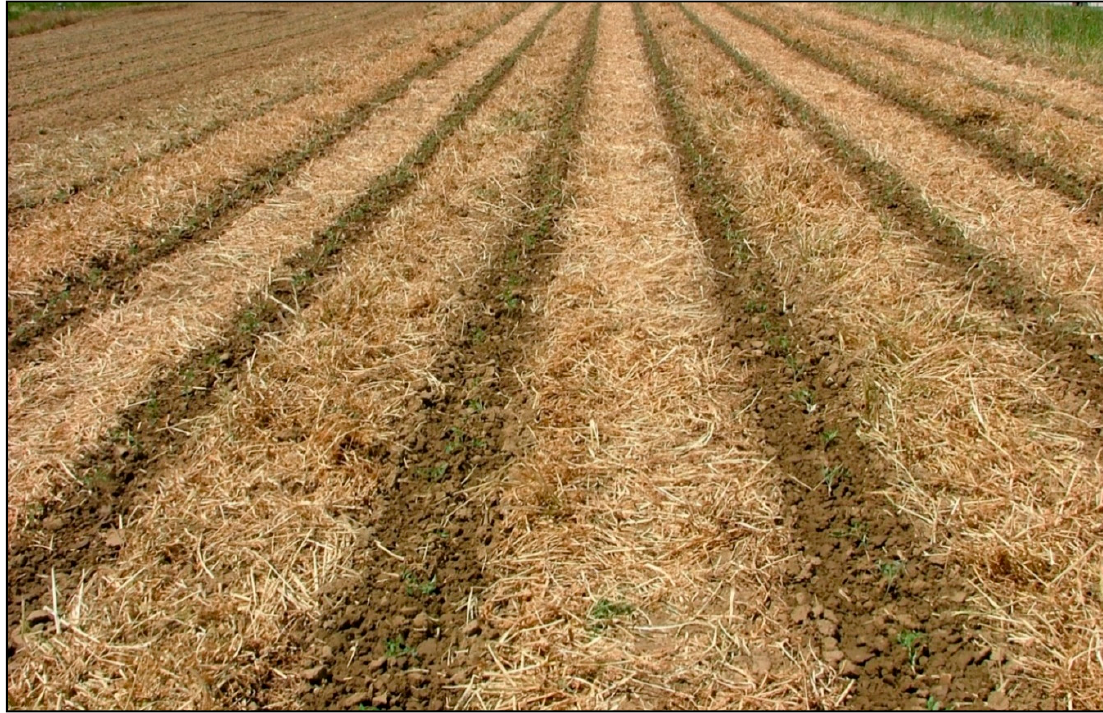
Figure 4. Effect of strip tillage on soil covered by dead mulch and tomato seedlings direct transplanted.